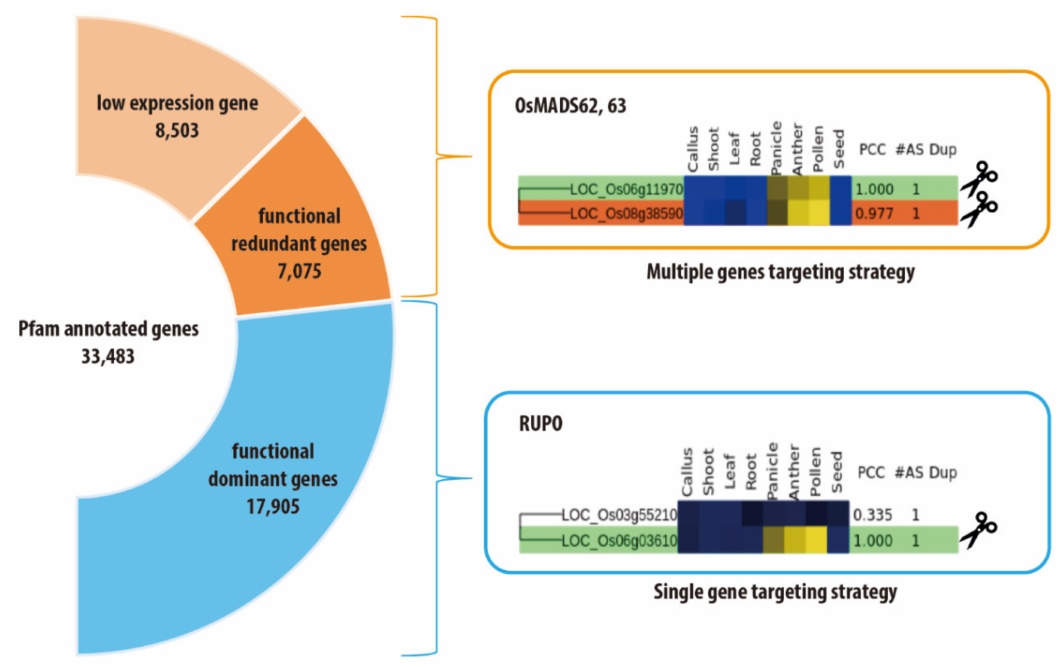
Figure 6. Case studies using the speed editing strategy for gene-family members: Rice contains 33,483 Pfam annotated genes. Among them, the functional significance of homologous genes within a family can be evaluated by integrated transcriptome data and Pearson’s correlation coe ffi cient. OsMADS62 and OsMAD63 in the same sisternode of the phylogenetic tree showed redundant expression in mature pollen with the highest expression, and their double mutant exhibited only a male sterile phenotype via a multiple CRISPR / Cas9 system. Conversely, RUPO showed predominant expression over LOC_Os03g55210 in mature pollen, and a single mutation of the RUPO gene via the CRISPR / Cas9 system caused a male sterile